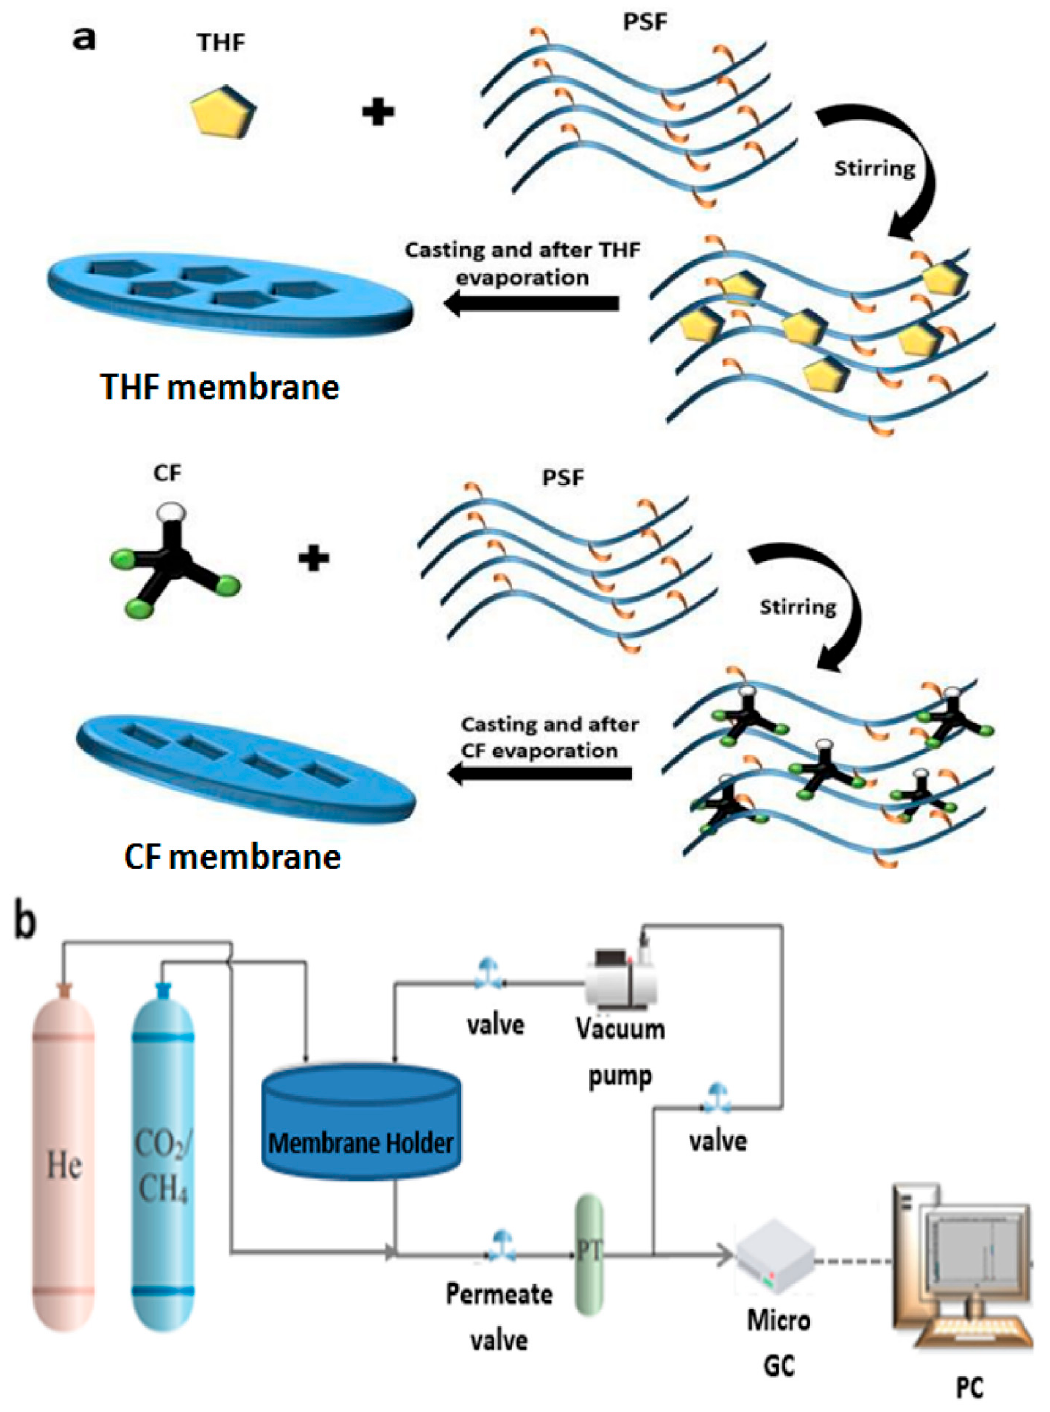
Figure 1. Schematics of ( a ) the shaping of PSF membranes by different solvents (i.e., THF and CF), ( b ) schematic system setup of CO 2 /CH 4 gas mixture separation.